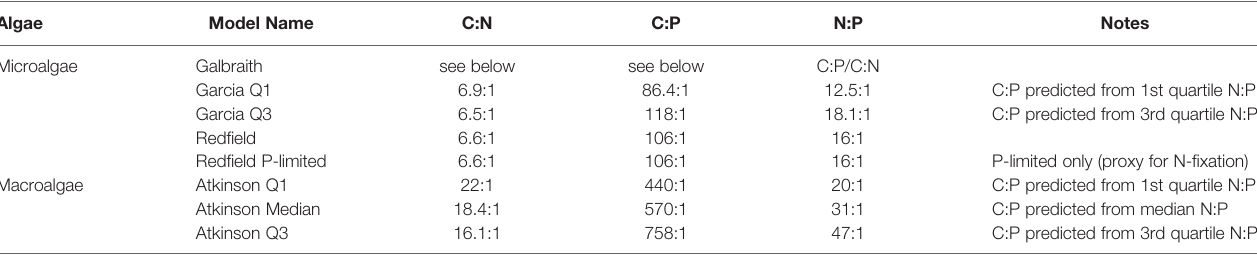
TABLE 1 | Carbon-to-nitrogen-to-phosphorus (C:N:P) ratios for the macroalgae and microalgae considered in this study.